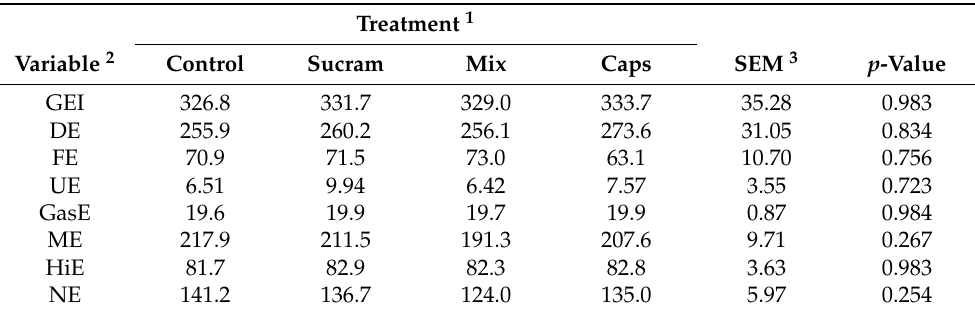
Figure 4. Effect of flavour (( A ); p = 0.049) and sex (( B ); p = 0.024) on daily weight gain per metabolic body weight of sheep fed unflavoured diet (control) or diet flavoured with sucram, capsicum or both (mix) expressed as the mean ± standard error. Means ± standard error with different letters (a, b) differ significantly ( p ≤ 0.05). Table 4. Effect of flavours on the total tract feed digestibility in lambs (expressed in percentage). Table 5. Effect of the flavours on the energy balance expressed in kilocalories per metabolic body weight per day (Kcal/day/Kg BW 0.75